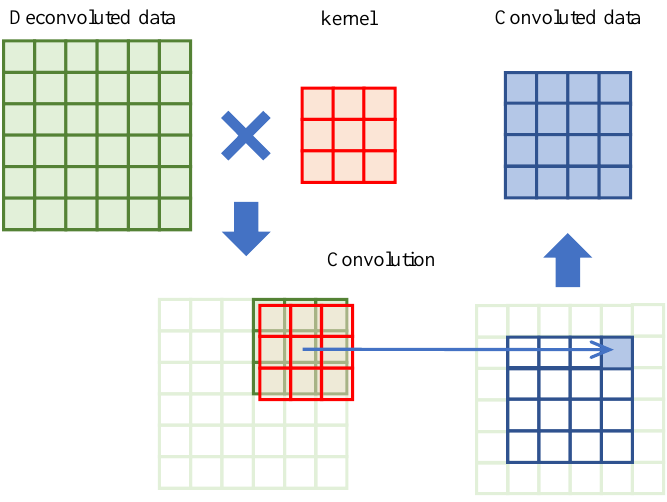
Figure 1. 2D convolution